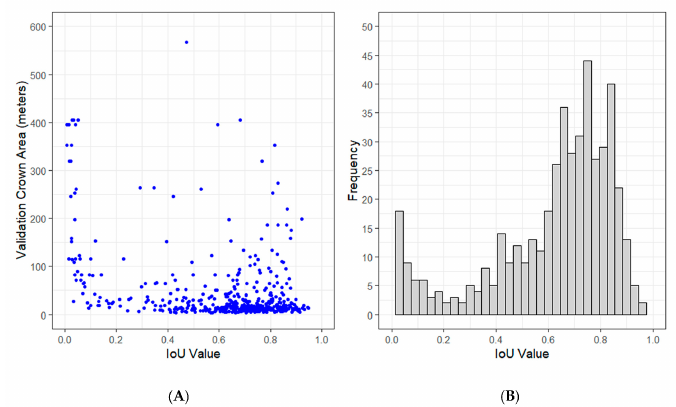
Figure 15. ( A ) Relation between the IoU value and the area of each crown in the evaluation set; ( B ) Distribution of IoU values.